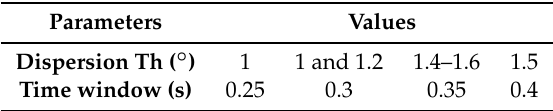
Figure 8. The four different features used to calibrate a dispersion-threshold identification (I-DT) algorithm with the points that fulfill all the conditions established (red points) in terms of the dispersion threshold for different time windows. Table 3. Optimum parameters using the criteria from number of fixations, mean time fixation, and percentage of fixations inside